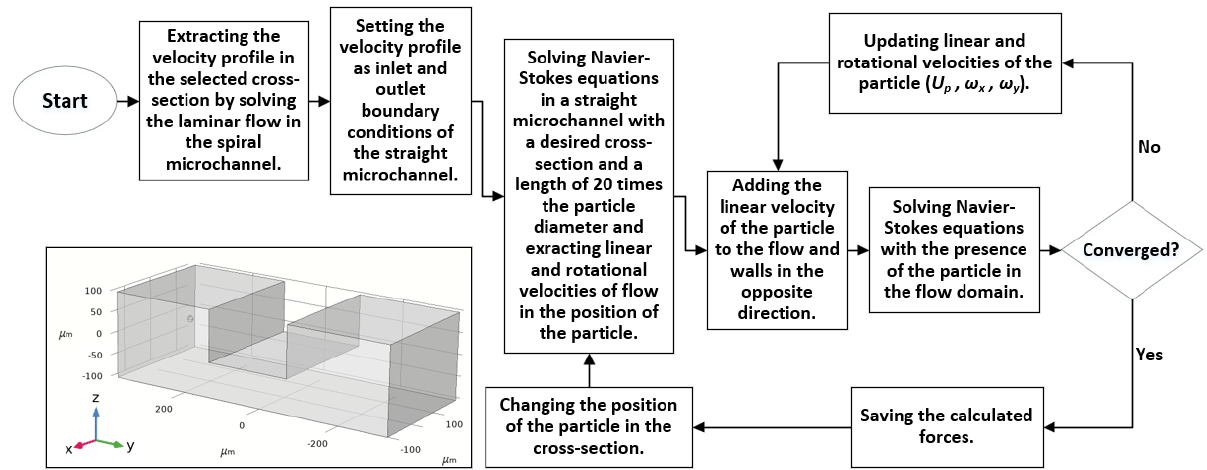
Figure 2. Flowchart of the numerical algorithm used in this study for the calculation of the forces acting on particles. The original algorithm was proposed to investigate particle inertial migration in a straight microchannel [31]. It was later modified to be used in a rectangular spiral microchannel [32]. We extended the original algorithm to run support the corresponding calculations of any other desired spiral microchannel cross-sections.